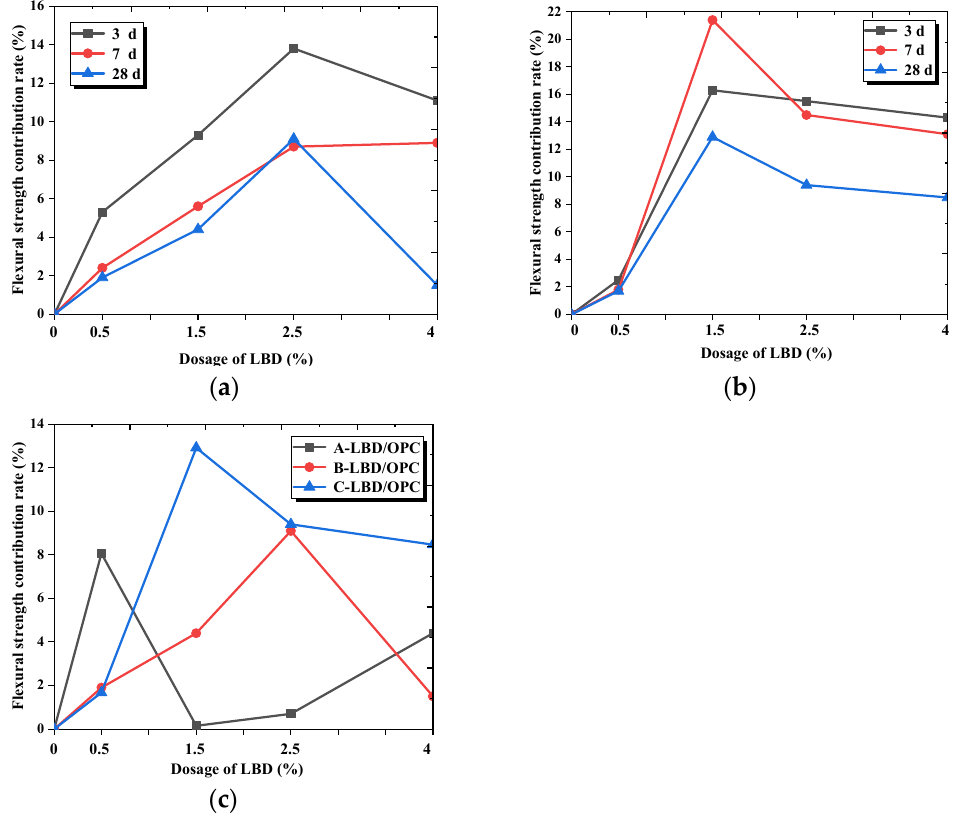
Figure 4. Flexural strength contribution rate of LBD to OPC materials: ( a ) Influence of B-LBD dosages; ( b ) influence of C-LBD dosages; ( c ) influence of LBD fineness levels (curing for 28 d).